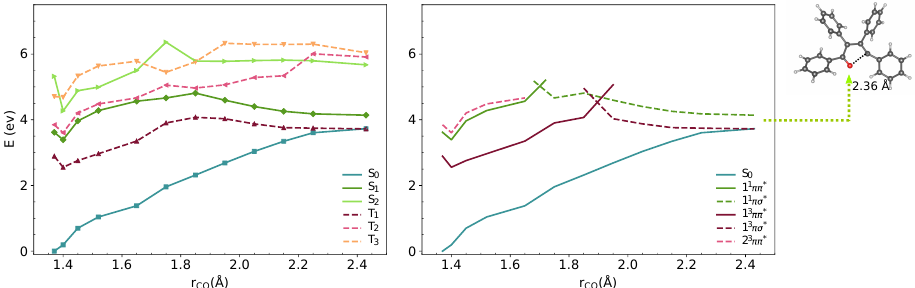
Figure 4. MS-3-CASPT2/CASSCF(10,10)/6-31G(d) energies of S 0 –S 2 and T 1 –T 3 states along interpo- lated pathway between FC point, S 1 minimum and S 1 –S 0 MECI geometry in crystal. The states are shown in adiabatic ( left ) and diabatic representation ( right ). The diabatic representation was obtained by connecting the excited states corresponding to the same type of transitions along the